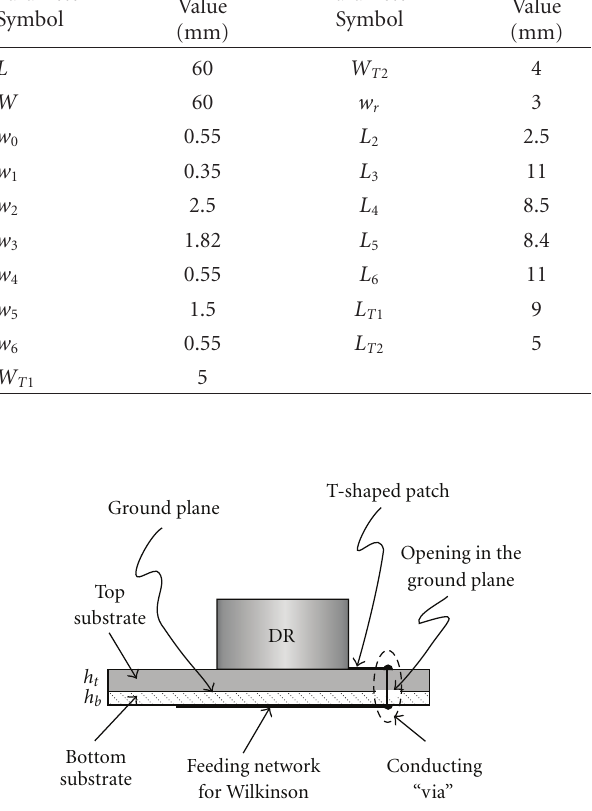
Figure 4: Side view of the proposed DRA structure.